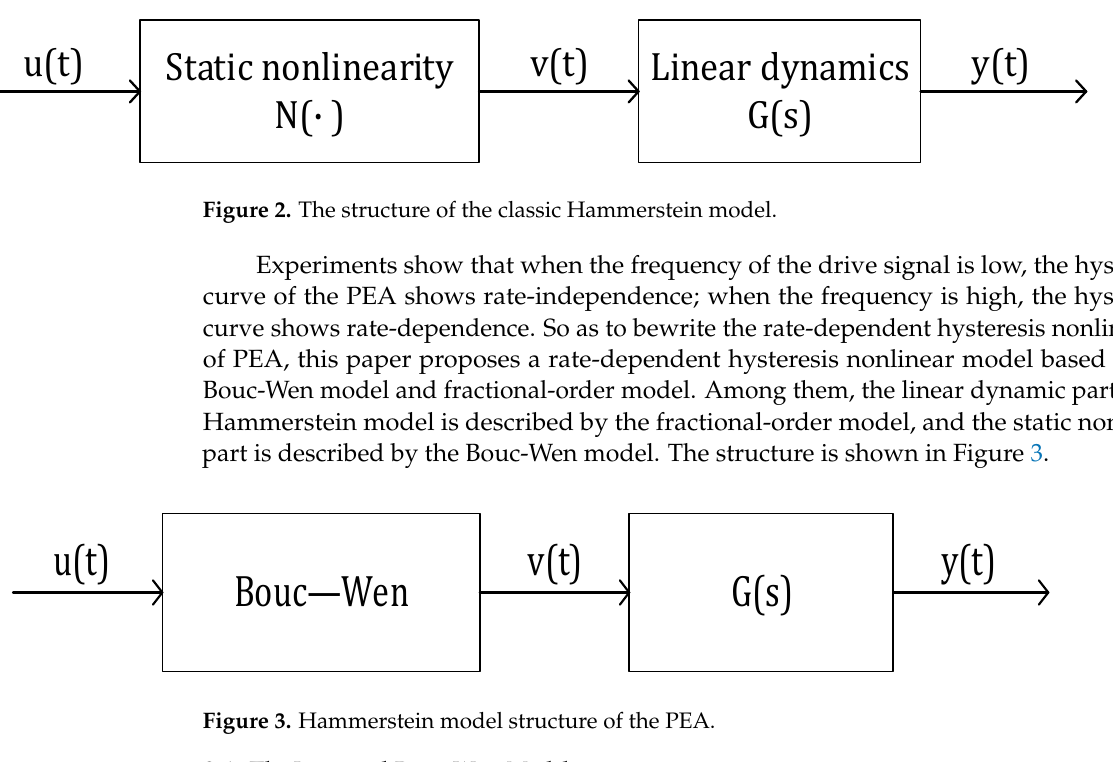
Figure 3. Hammerstein model structure of the PEA.